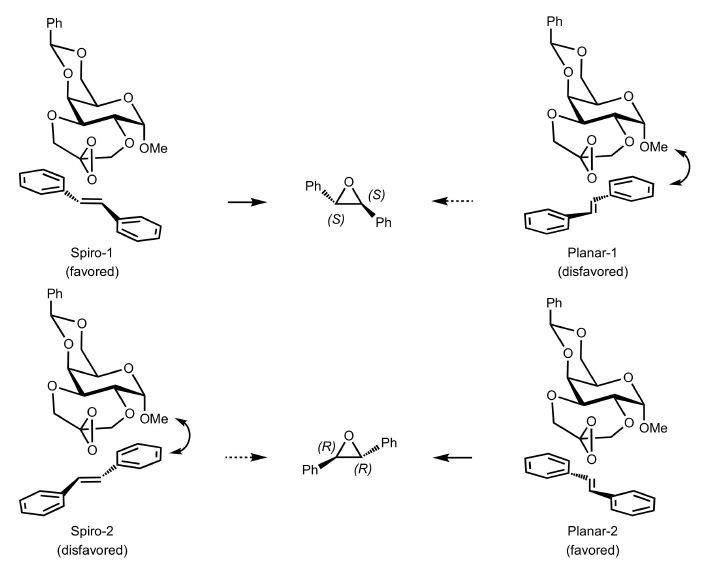
Figure 21. Competitive transition